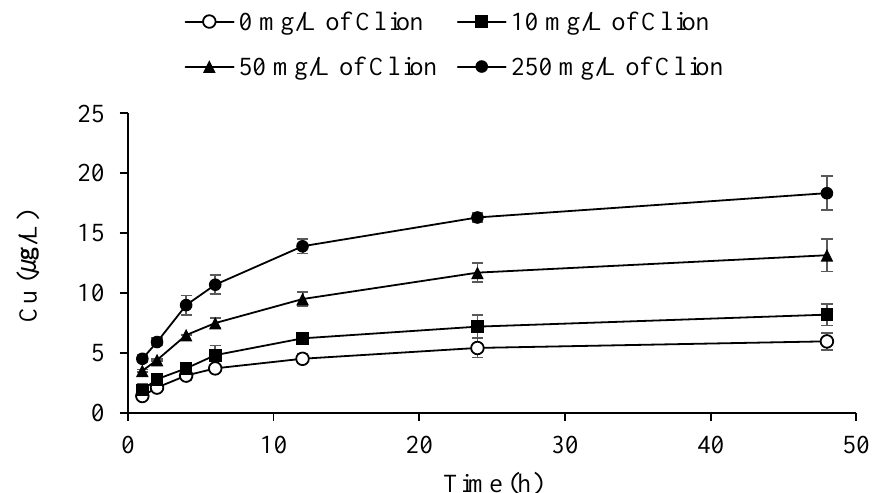
Figure 6. Total copper concentration in 200 mL DI water at various time points as a function of chloride ion concentration. Error bars represent standard error.